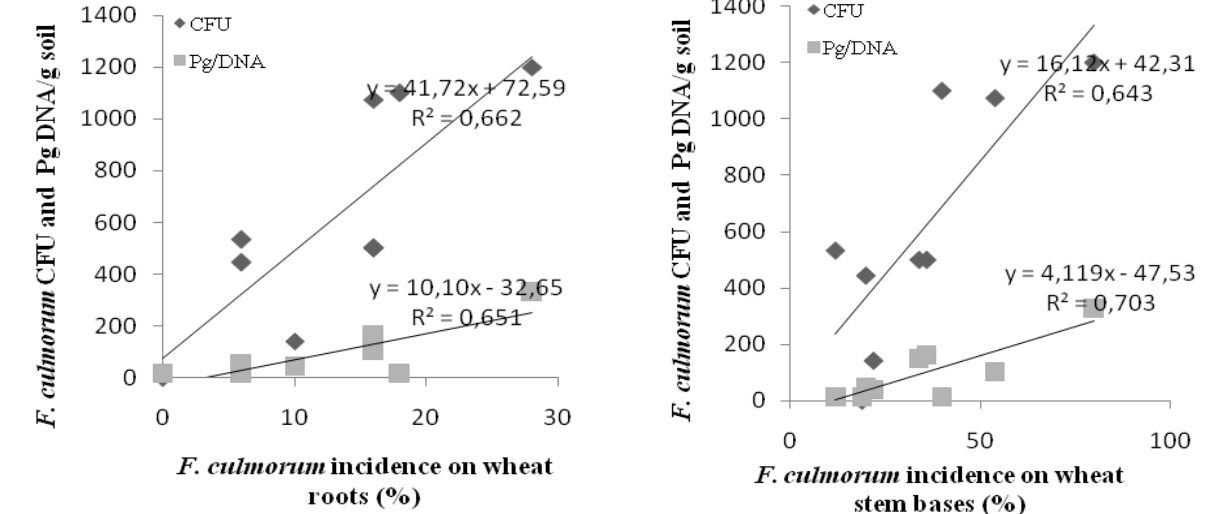
Figure 8. Correlations between Fusarium culmorum incidence (%) on wheat roots (A) and stem bases (B) and inoculum levels of F. culmo- rum left in the soil after 1 year, for three demonstration trials at Fernana, Tunisia.